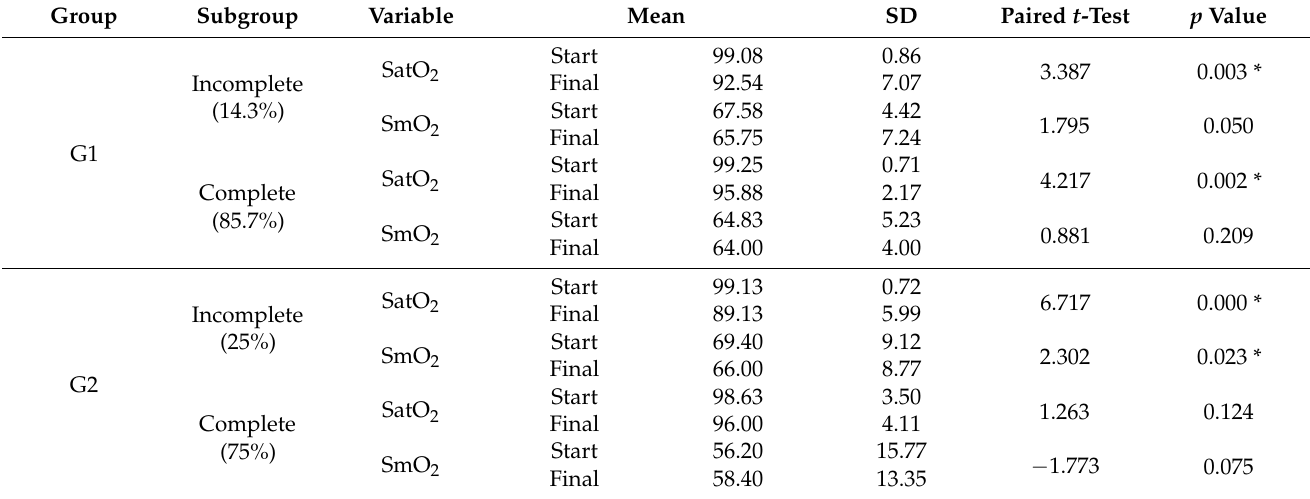
Table 5. Differences in SatO 2 and SmO 2 in the second test separated by group and subgroup.